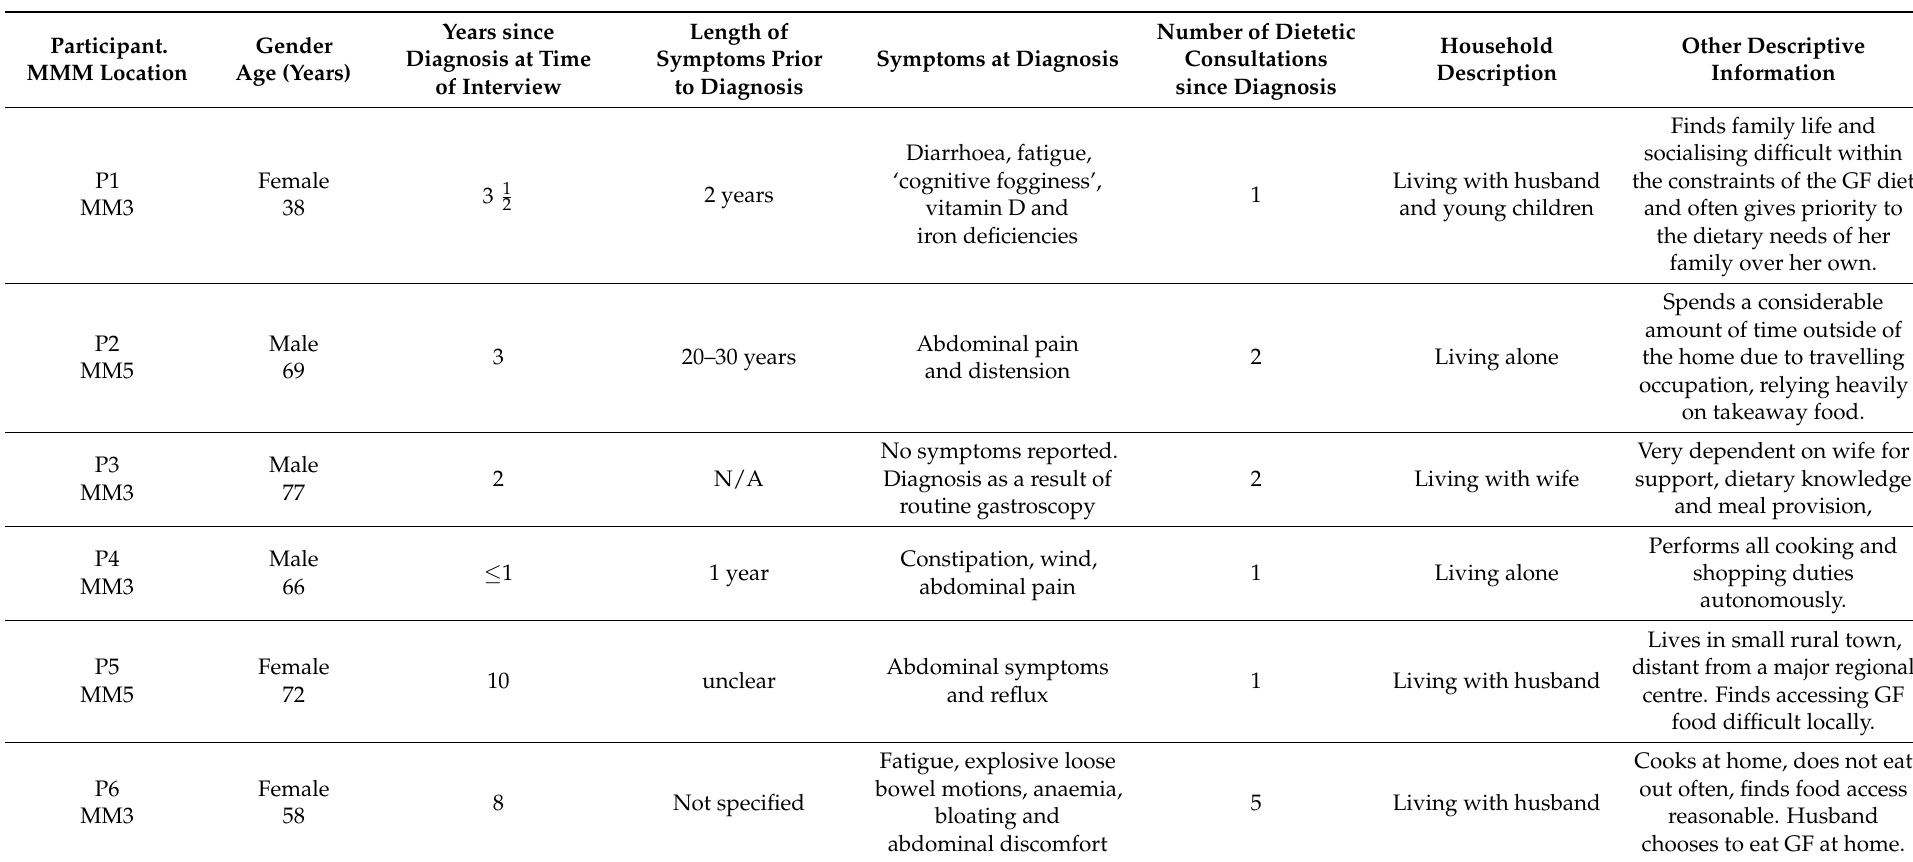
Table 1. Participant demographic information, symptoms at diagnosis, number of dietetic consultations, and other descriptive information.